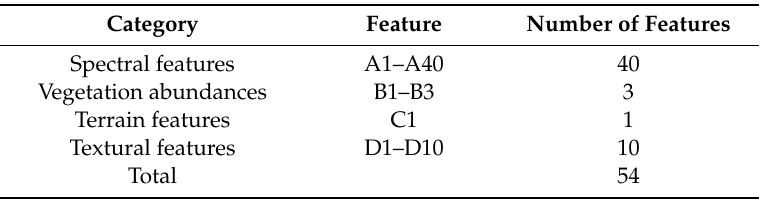
Table 2. Features selected for image